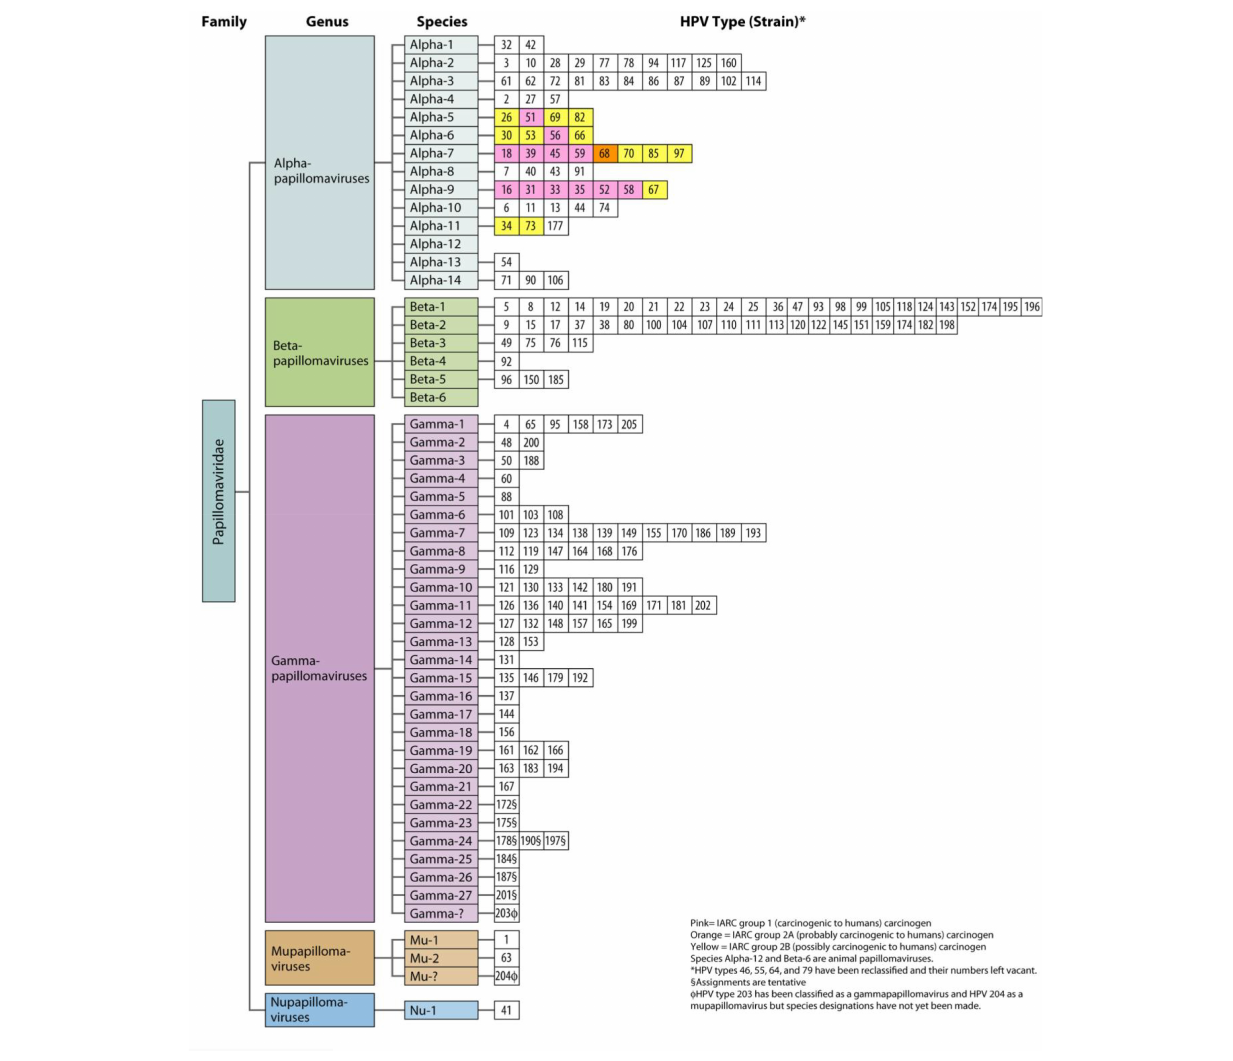
FIGURE 1 | HPV classification based on the nucleotide sequence of the capsid protein L1 gene (Burd,